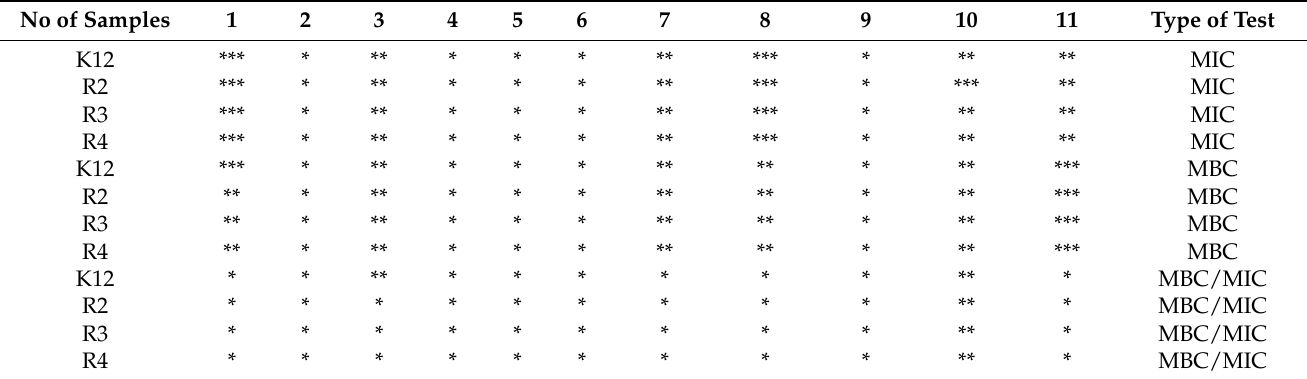
Table 3. Statistical analysis of all 11 analyzed compounds at p < 0.05 *, <0.01 **, <0.001 *** in MIC, MBC and MBC/MIC tests. Pyridine derivatives 1–11 were used